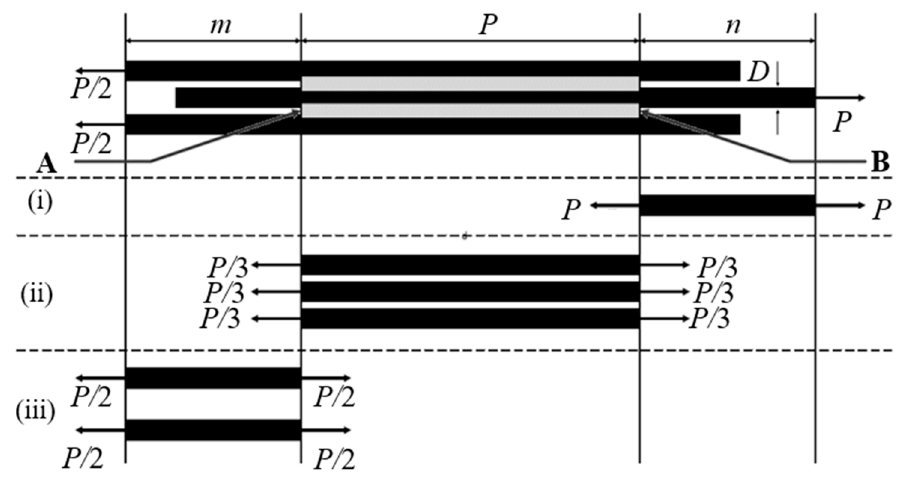
Figure 2. Schematic of the double shear method.